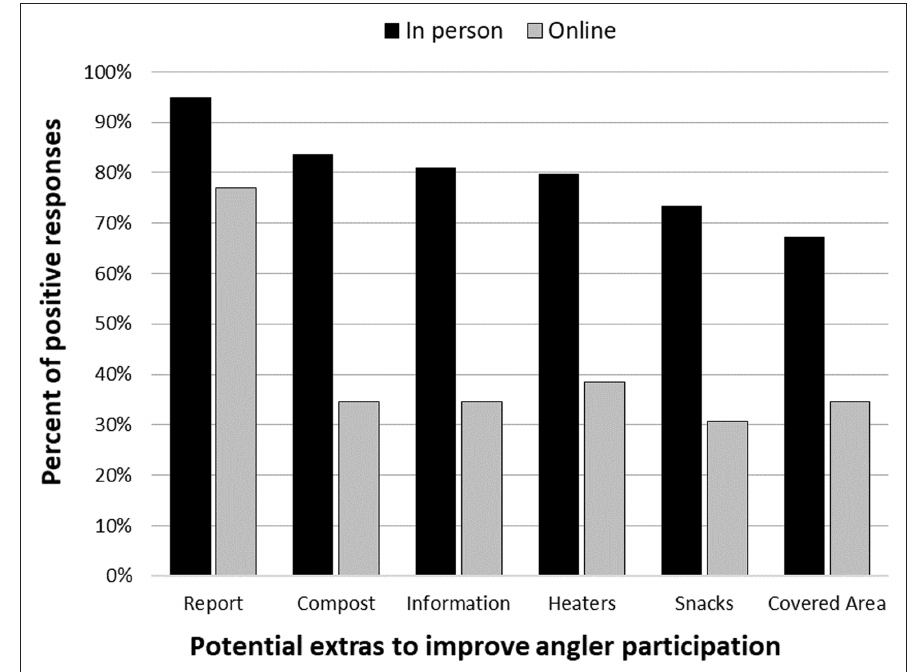
Figure 3: Potential extras influencing likelihood of angler participation in the hypothetical citizen science program. Anglers could select more than one